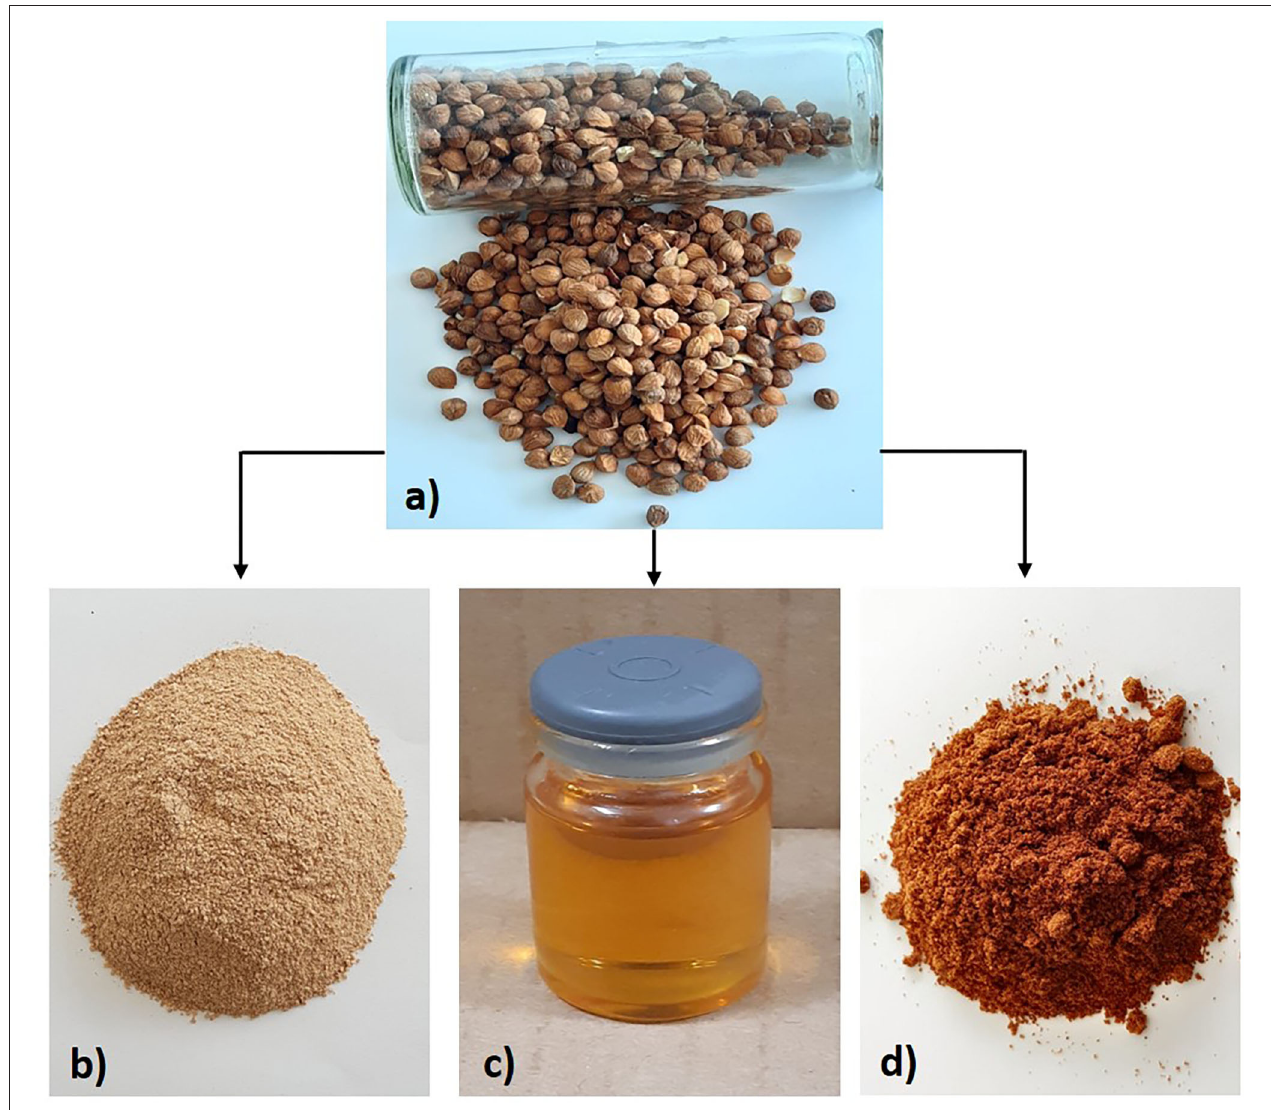
FIGURE 2 | (a) P. serotina (var. capuli) seed and their by-products; (b) shell, (c) oil and, (d) paste.